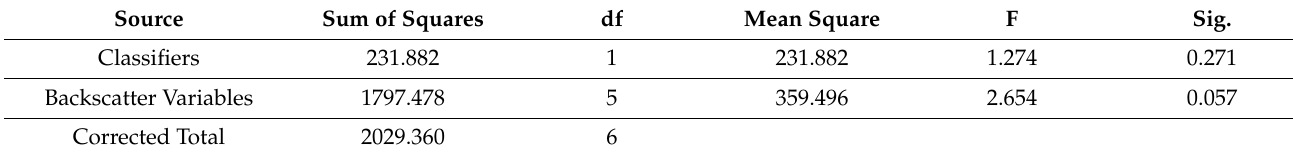
Table 6. ANOVA for the effect of classifiers and backscatter variables on BCR (%).